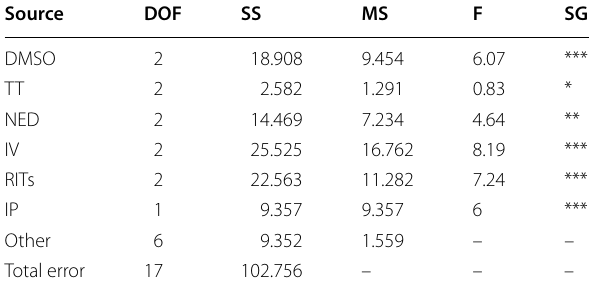
Table 6 Variance analysis on MTD